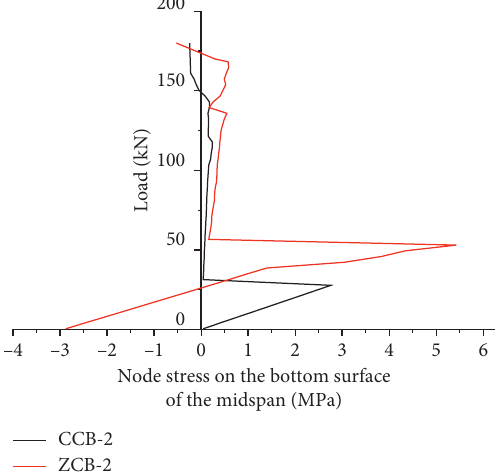
Figure 32: Stress history of the middle node on the top surface of the middle